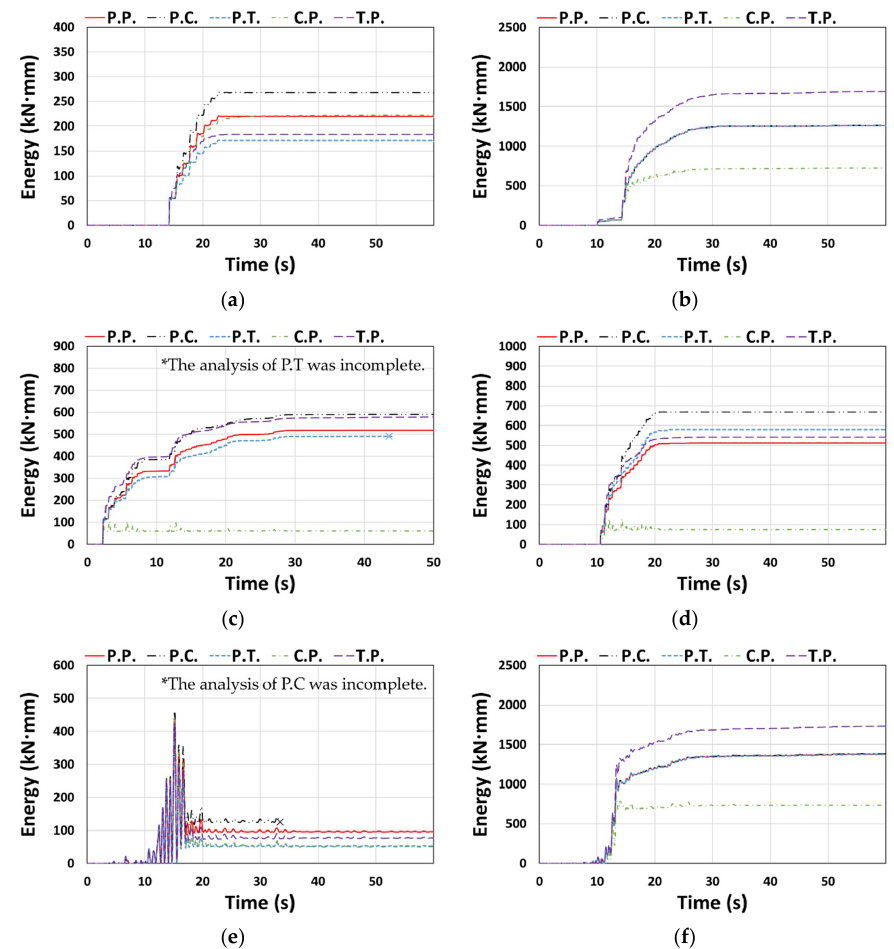
Figure 16. Cumulative dissipated energy: ( a ) Type 1 (Northridge, X-dir.), ( b ) Type 1 (Northridge, Y-dir.), ( c ) Type 2 (El Centro, X-dir.), ( d ) Type 2 (Northridge, Y-dir.), ( e ) Type 3 (Northridge, X-dir.), and ( f ) Type 3 (Northridge, Y-dir.).